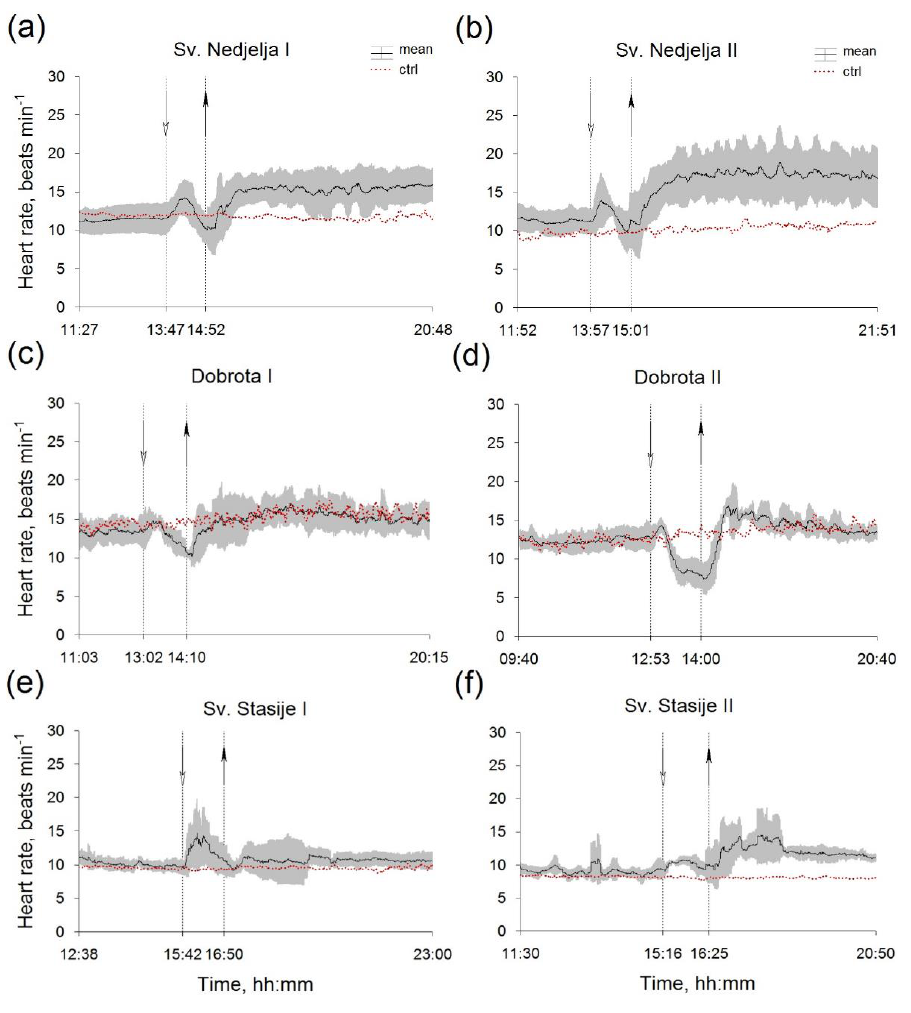
Figure 3. Mean HR within groups of Pinna nobilis specimens sampled from Sv. Nedjelja ( a , b ), Dobrota ( c , d ) and Sv. Stasije ( e , f ), before, during (between dashed lines) and after experimental treatment. Abbreviations: ctrl — control (red dotted lines); white head arrows — onset of salinity change by distilled water; black head arrows — onset of restoration of initial salinity values by salt addition; I — the first experiment; II — the second experiment. There was no statistically significant difference ( p > 0.05) of tested parameters in comparison between the two experiments carried out within the groups of mussels from the same sampling sites. The shell length of mussels from Dobrota and Sv. Stasije was significantly higher in comparison to Sv. Nedjelja, and the specimens from Sv. Stasije were significantly longer in comparison to Dobrota (Figure 4a). Statistically significant differences in shell width between the Sv. Nedjelja and Dobrota sites were not observed, while the specimens from Sv. Stasije were significantly wider in comparison to other sites (Figure 4b).